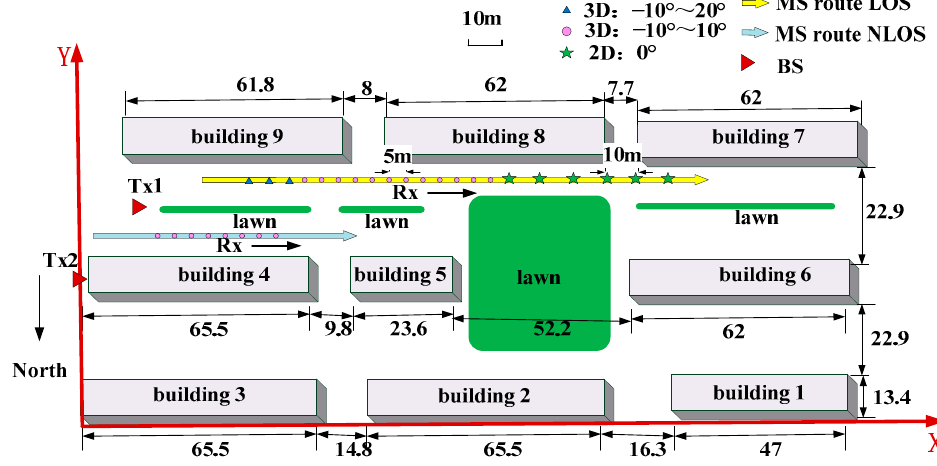
Figure 6. Plot of measurements in urban microcells. The measurement parameters are listed in Table 1. The complex relative dielectric permittivity of the wall is taken as ε r = 3 + 0.005 i based on the value provided in the literature [32]. The farther the receiving antenna is from the transmitting antenna, the smaller the influence of the elevation angle. Therefore, the station that is far away from the transmitting antenna only measured an elevation angle of 0 ◦ and azimuthal angle of 360 ◦ , as shown in Figure 6. In Figure 6, 3D indicates that the elevation and azimuthal angles are measured; 2D indicates the experimental data where the elevation angle is 0 ◦ and the azimuthal angle is 360 ◦